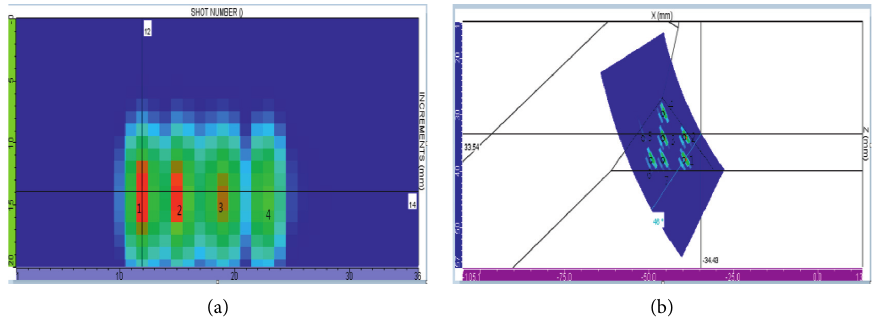
Figure 2: Diagram of simulation: (a) C scanning; (b) sectorial scanning.